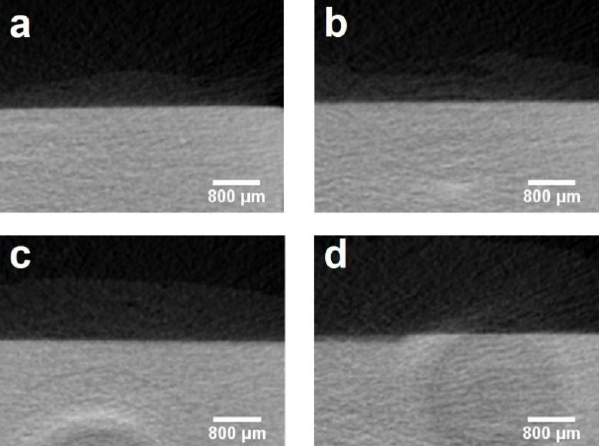
Figure 5. Micro-CT images of enamel in four groups: ( a ) Group 1 (SBAG); ( b ) Group 2 (SBAG+F); ( c ) Group 3 (F); ( d ) Group 4 (Control). Table 1. The mean lesion depths and mineral loss of dentine and enamel after pH-cycling. Group Lesion Depth in Mineral Loss of Lesion Depth in Mineral Loss of Group Dentine (μm) (Mean ± SD) Dentine (g/cm 3 ) (Mean ± SD) Enamel (μm) (Mean ± SD) Enamel (g/cm 3 ) (Mean ± SD) SBAG (1)